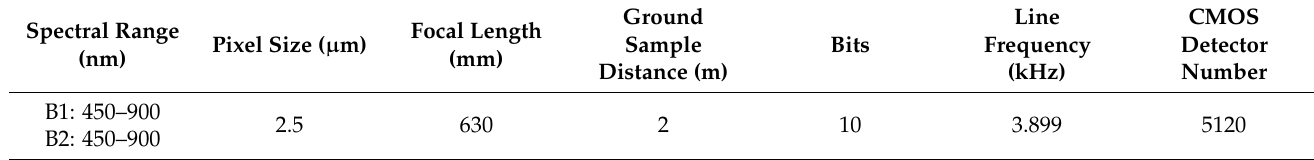
Table 1. Description of the intelligent camera of the “MN200Sar-1”